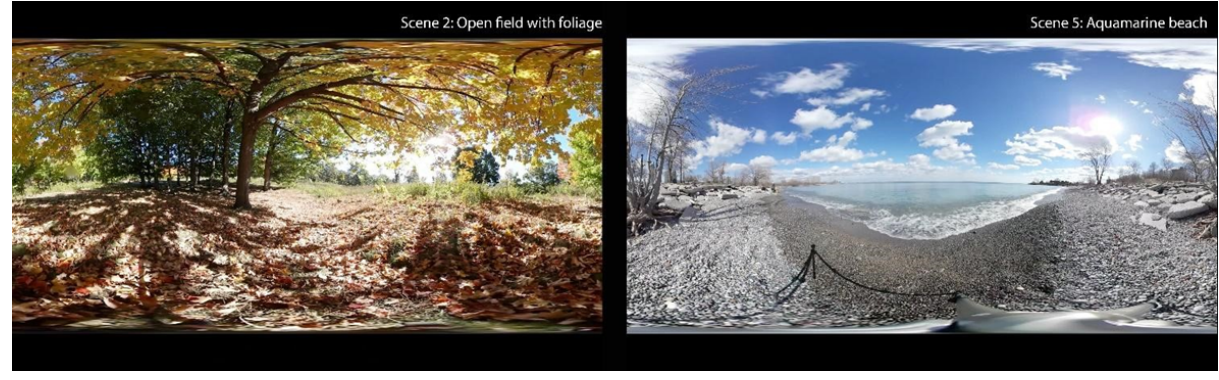
Figure 1. 2D screen capture of 2 of the 5 virtual reality scenes (scene 2: open field with foliage and scene 5: Aquamarine beach).